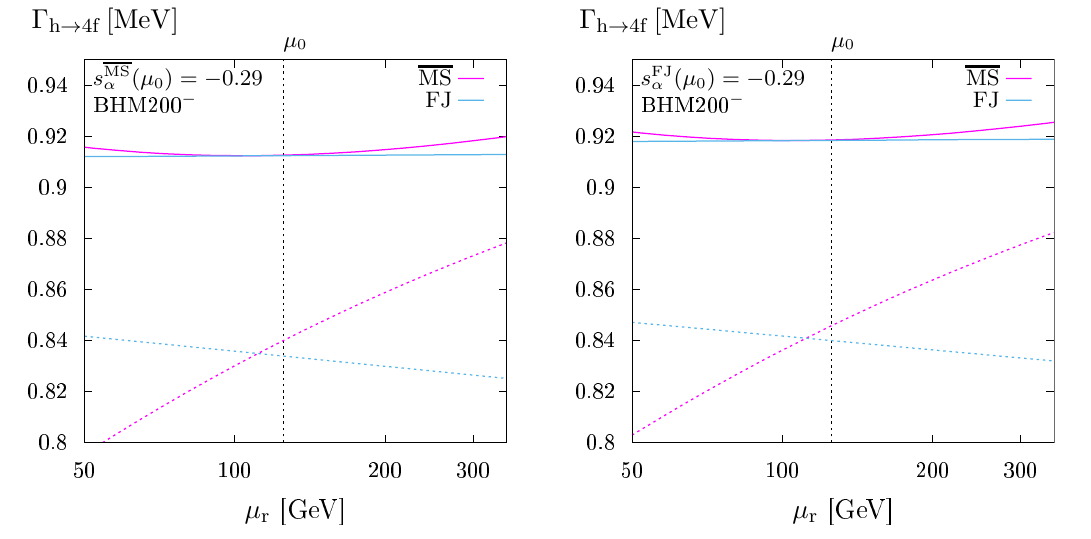
Figure 26 . As in (cid:12)gure 11, but for benchmark scenario BHM200 (cid:0) .